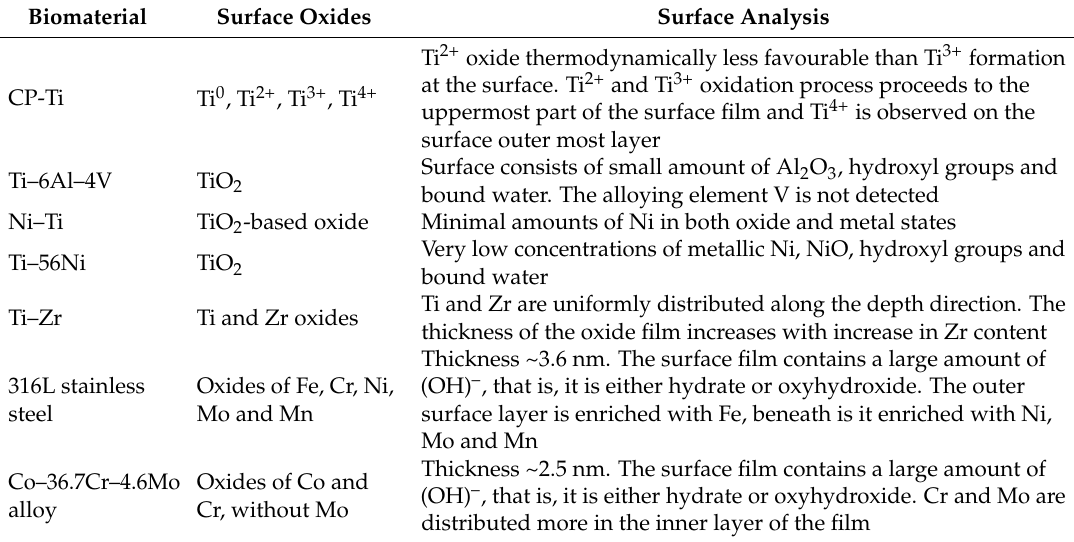
Table 4. Analysis of the surface oxide film on various metallic